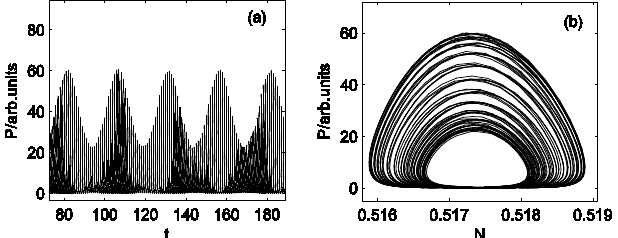
Fig. 2. Different beating. (a) beating. (b) an orbit.